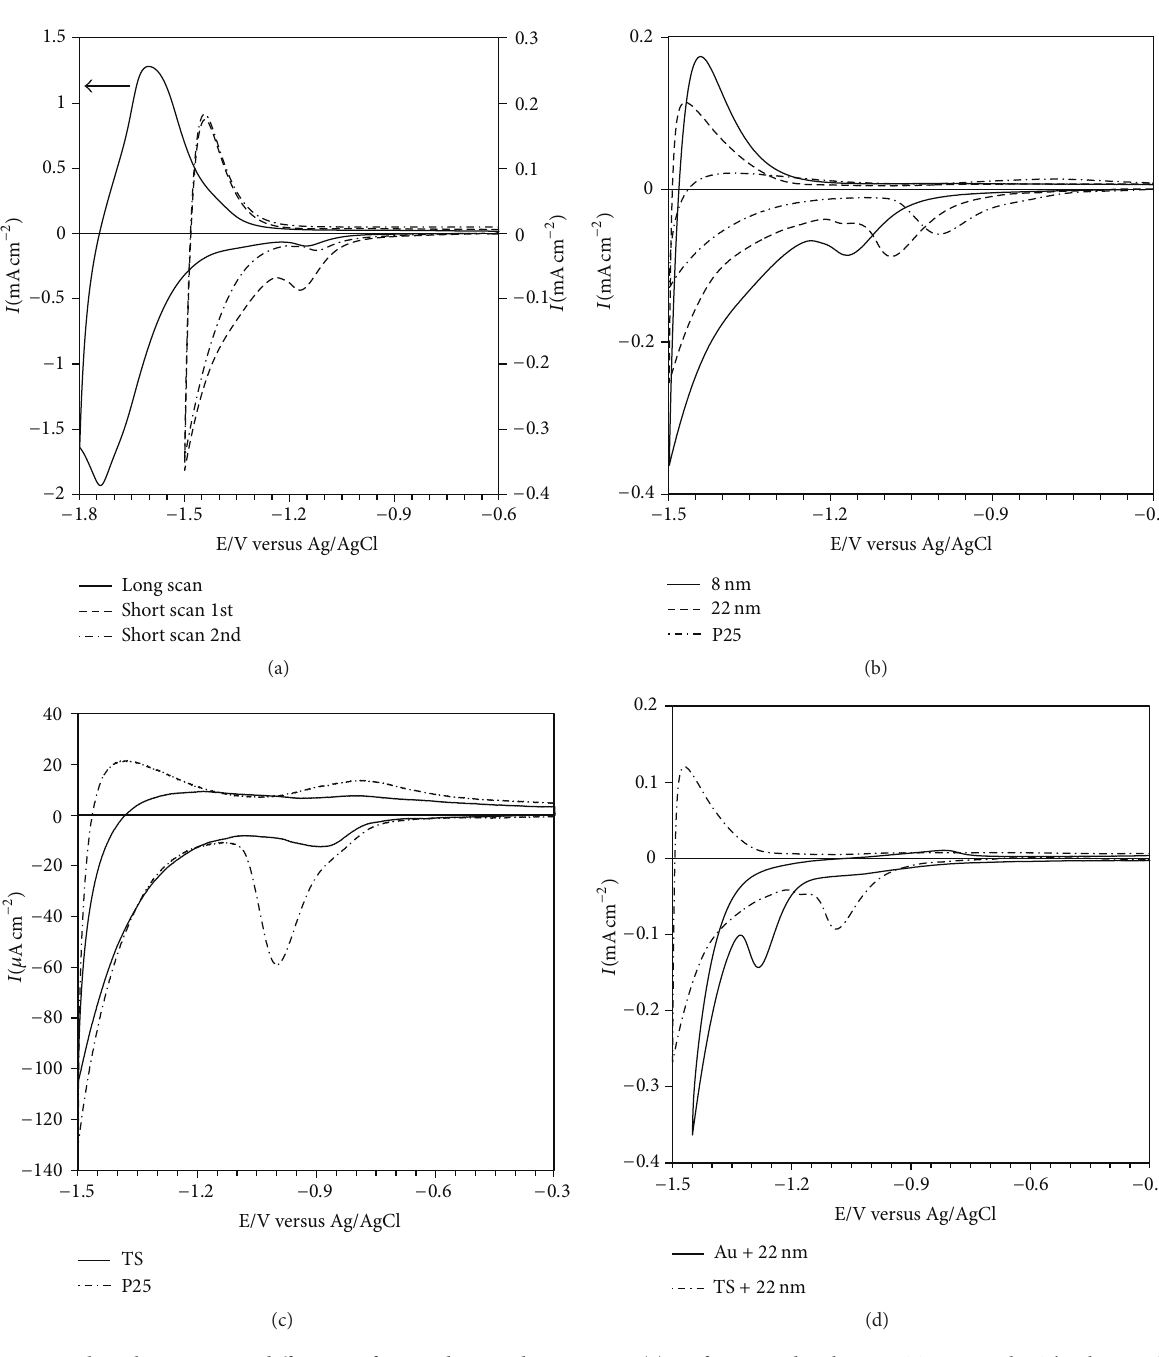
Figure 3: Cyclic voltammetry on different surfaces in deaerated 0.1M KOH. (a) Surface coated with 22nm TiO 2 particles. The short and long scans are made on different samples. Note that the scale to the left refers to the long scan. For the short scan, both the 1st and the 2nd cycles are shown. Comparison between surfaces (b) coated with different nanoparticles sizes, (c) uncoated turned surface and coating with P25, and (d) different substrates. Sweep rate is at 50 mVs −1